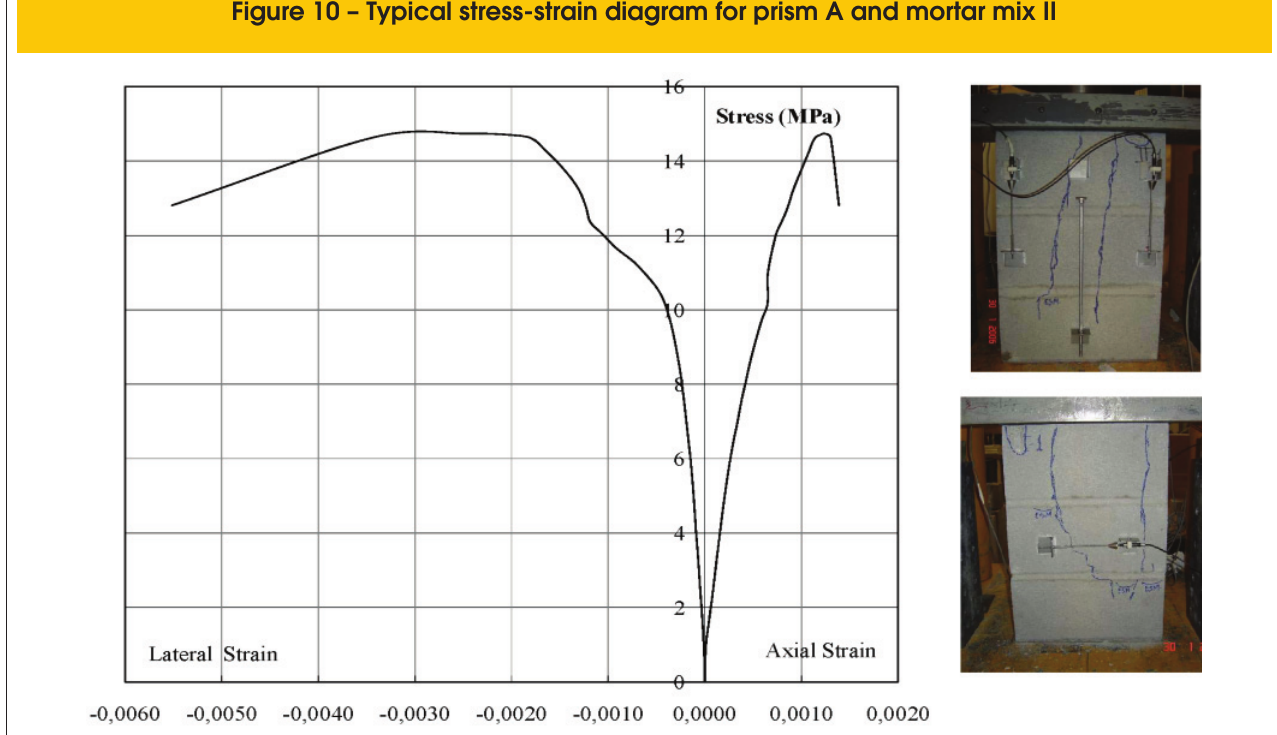
Figure 10 – Typical stress-strain diagram for prism A and mortar mix